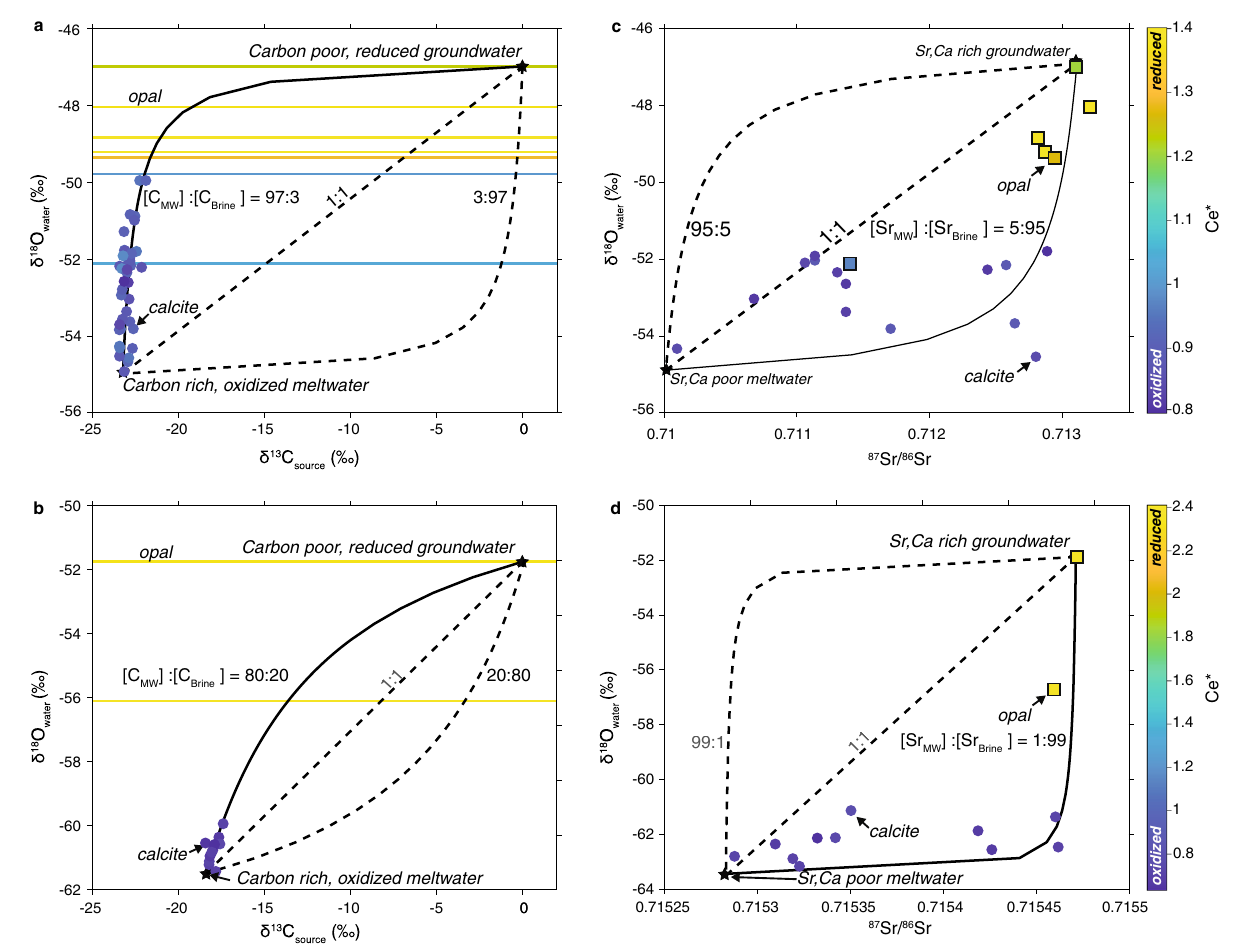
Fig. 4 | Stable isotope mixing models for precipitates PRR50489 and MA113. a δ 18 O of the precipitating fl uid versus δ 13 C CaCO3 (we interpret δ 13 C CaCO3 to indicate the composition of the C source), plotted for PRR50489 calcite and opal. Endmembers (stars) include an opal precipitating fl uid that is a carbon poor,brine with loweroxygen contents;and acalciteprecipitating fl uidthat isa carbon rich, oxidizing meltwater. Solid curved line represents mixing model between the two endmembers 111 . To fi t calcite data, mixing model requires meltwater to have a total carbon concentration 40-fold higher than brine. b As in a , but data are from sample MA113. To fi t calcite data, mixing model requires meltwatertohaveatotalcarbonconcentration fi vefoldhigherthanbrine. c δ 18 O